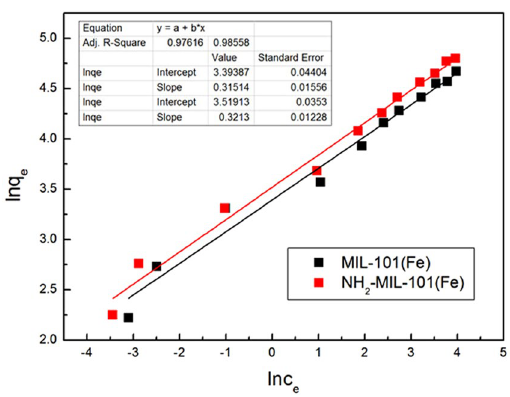
Figure 13. Freundlich plots of the isotherms for phosphate adsorption on Fe-based MOFs ( Adsorbents, 12 mg;